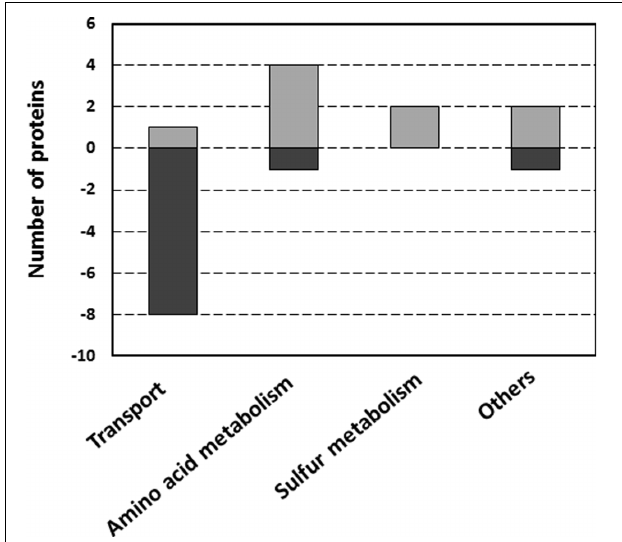
FIGURE 2 | Functional classification of proteins with differential abundance in wild type and ctpA mutant R. leguminosarum , according to their biological function. The category “Others” includes one protein in each of the following categories: energy metabolism, protein folding and signal transduction. Assignments were made according to the Clusters of Orthologous Groups of proteins